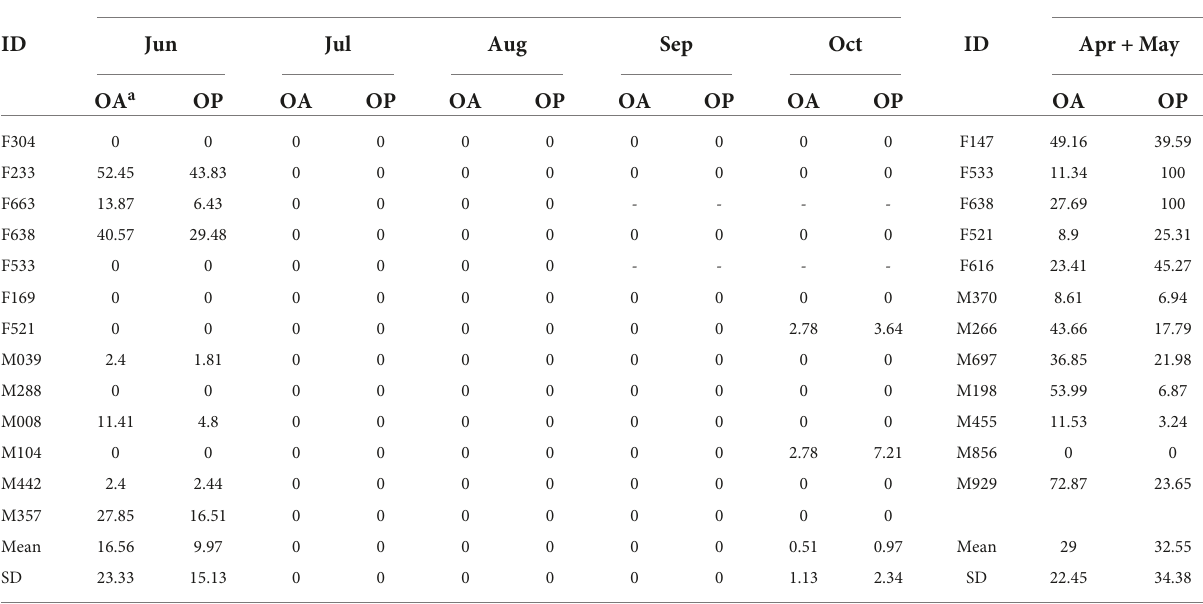
TABLE 1 Overlap area (OA) of a single individual’s home range with other individuals and the percentage of overlap (OP) in its home range in different